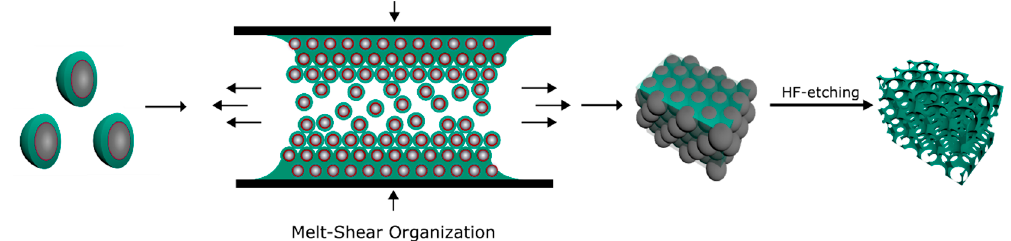
Figure 3. Fabrication of opal films using the melt-shear organization technique and preparation of an inverse opal by HF etching of the SiO 2 core particles. inverse opal by HF etching of the SiO 2 core